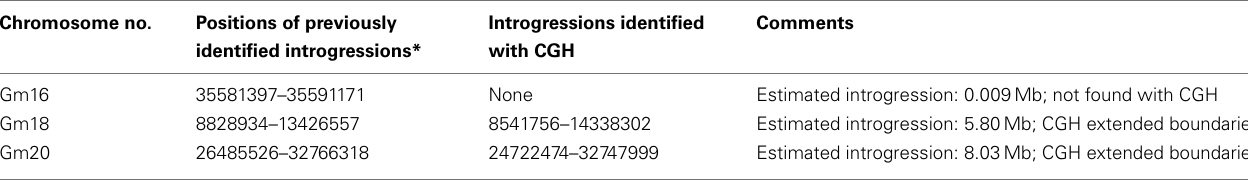
Table 1 | Comparison of differential G. soja introgression sites among the HiPro and LoPro NILs. Chromosome no.